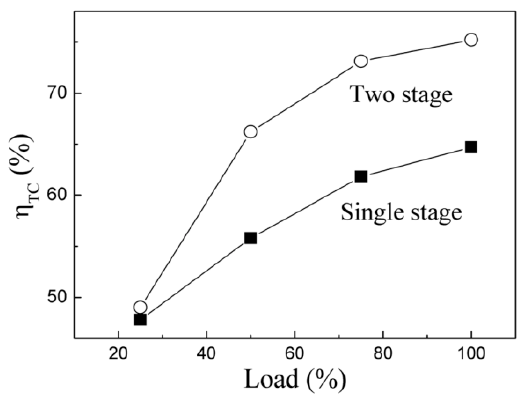
Figure 5. Comparisons between flexible two-stage and single-stage turbocharging [95].